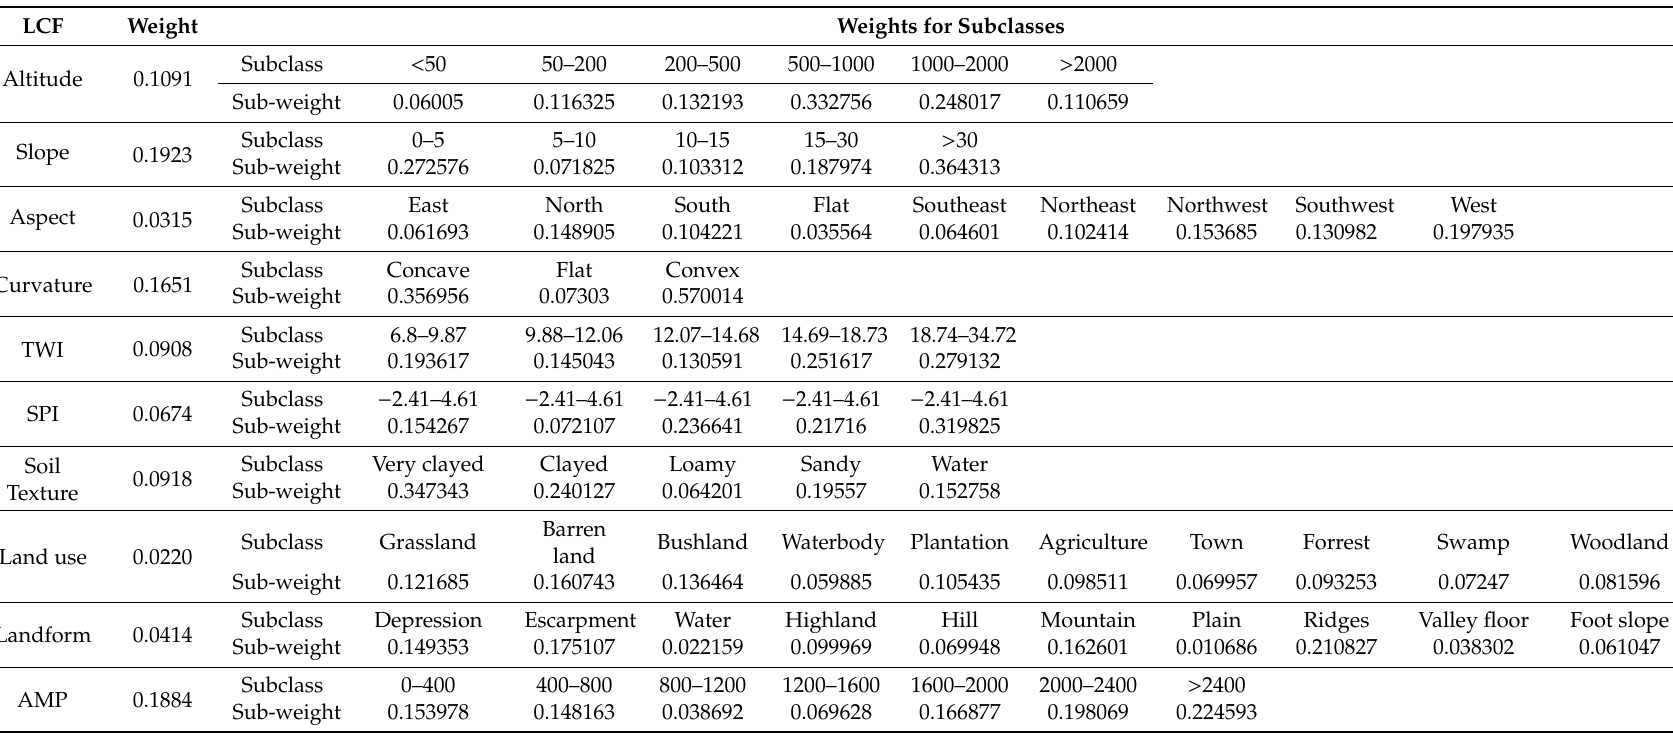
Table 6. Calculated weights for the LCFs and their